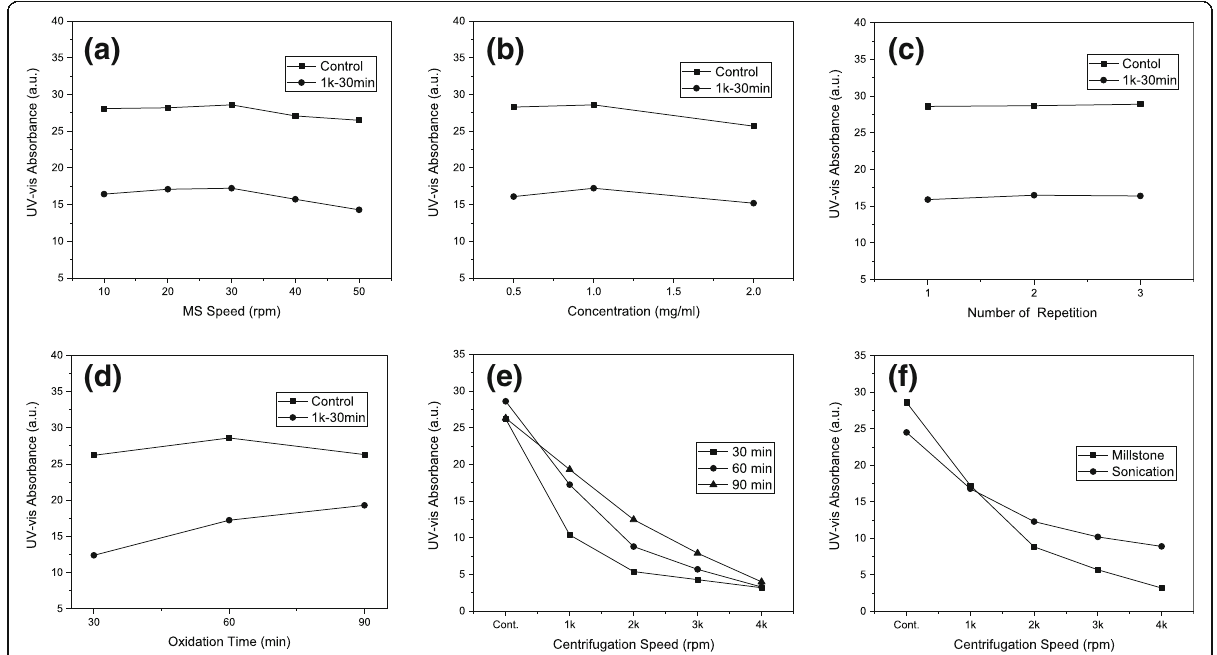
Fig. 3 UV-vis absorbance of MS-exfoliated MOG solution. Effect of a MS rotation speed, b solution concentration, c number of repetition, d oxidation time, and e oxidation time with centrifugation rpm and f comparison of MS and sonication